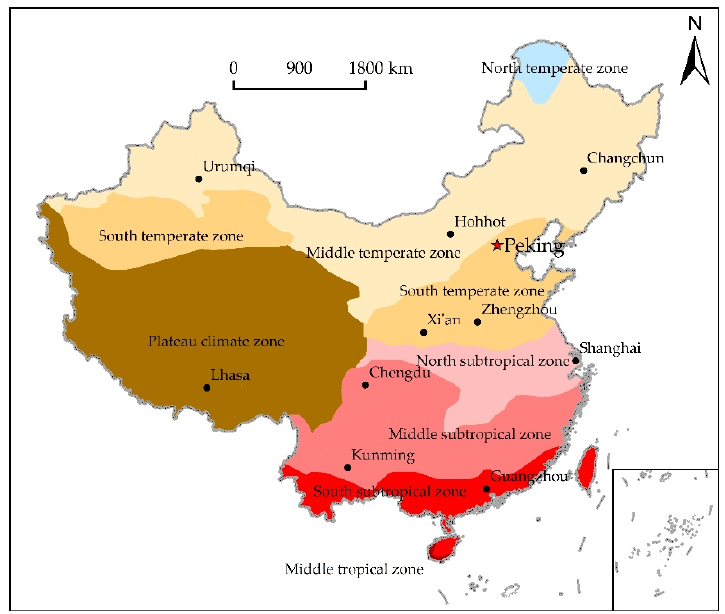
Figure 10. Climatic regionalization of China.